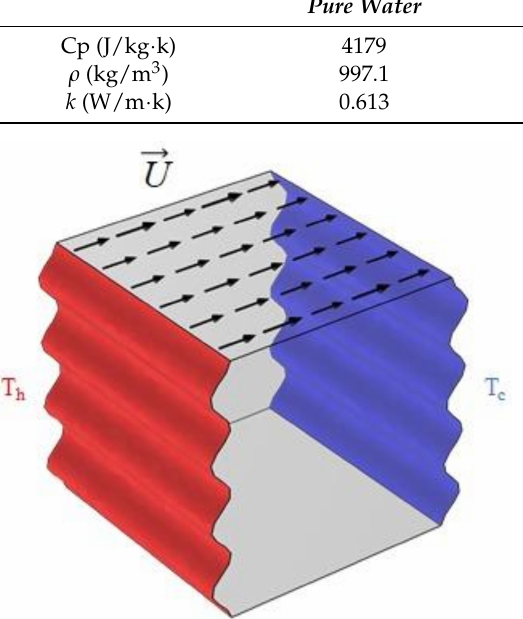
Table 1. Nanoparticles and base fluid thermophysical properties [42,43]. Pure Water